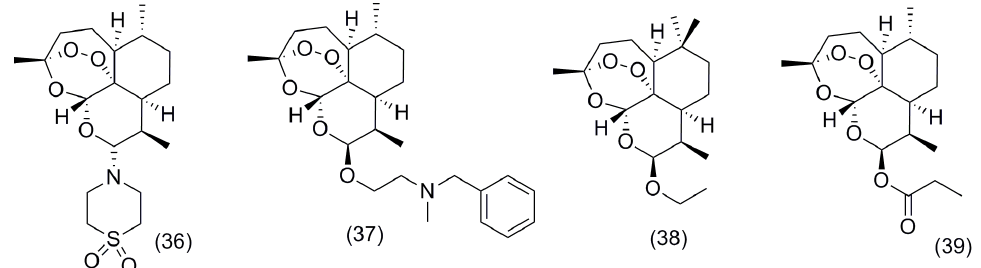
Figure 14 - Structures of ART derivatives 36-39